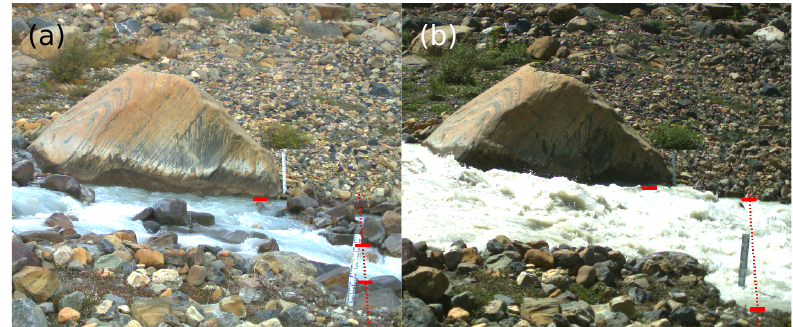
Figure 11. The width measurement at low (a) and high (b) discharges. The left line is the water level at the boulder station. The dashed line is the cross section and the right ticks are the detected flow edges.